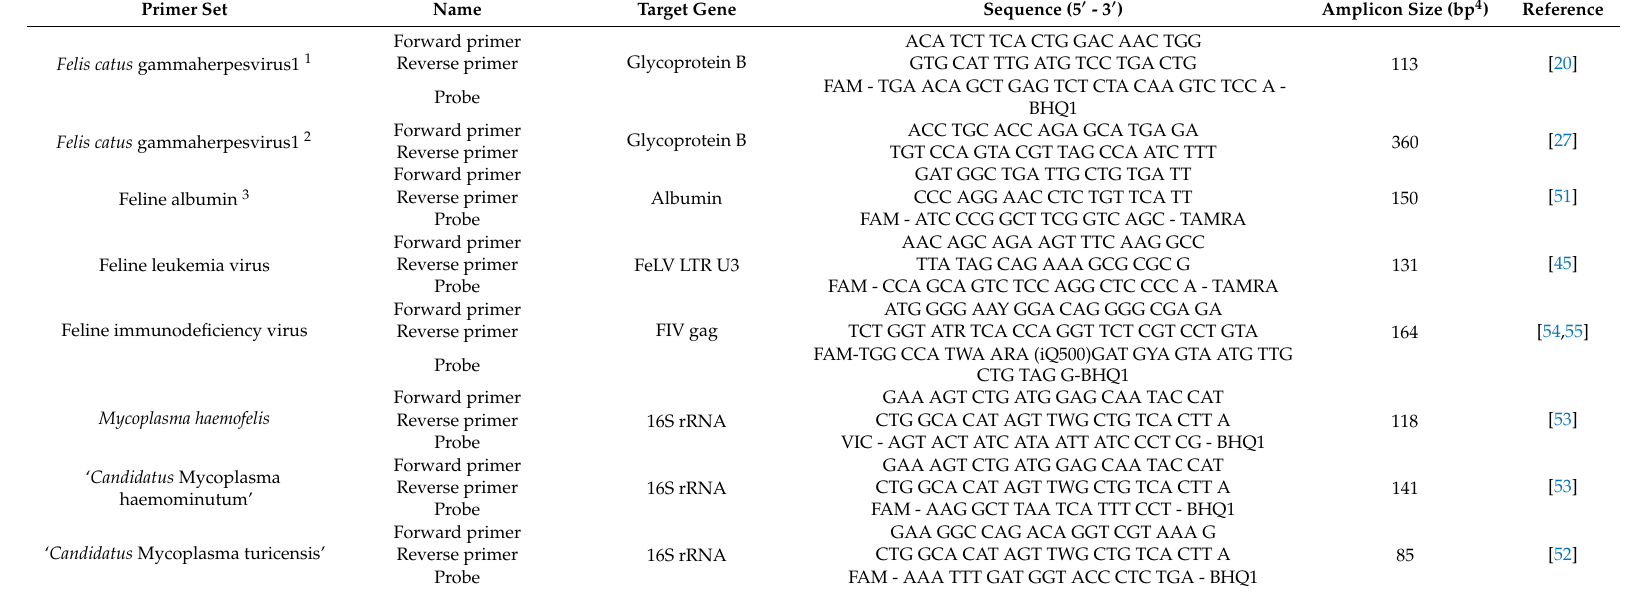
Table 1. Primers and probes employed in this